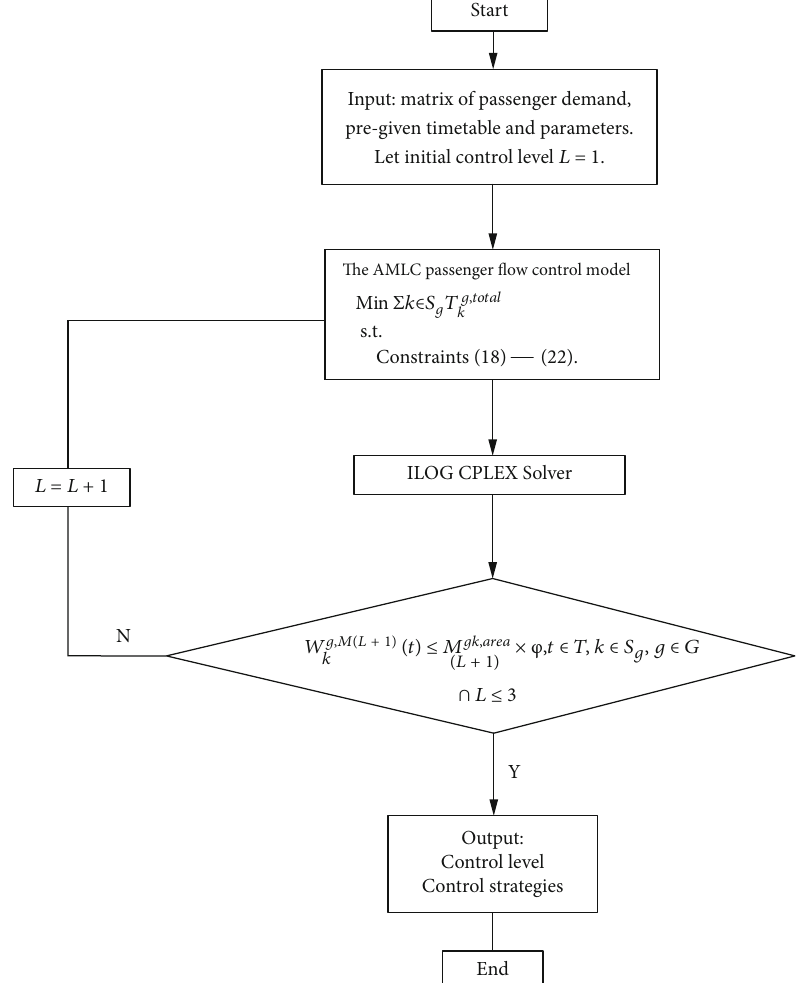
Figure 4: The process of the adaptive control